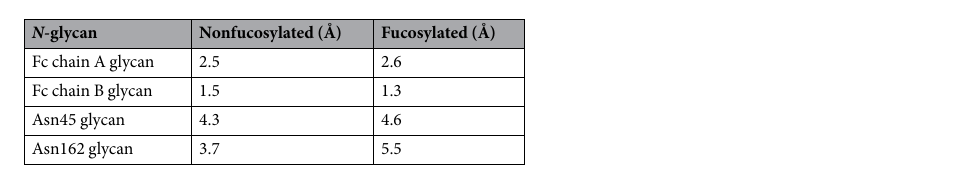
Table 1. RMSF values for N -glycans of IgG1-Fc and Fc γ